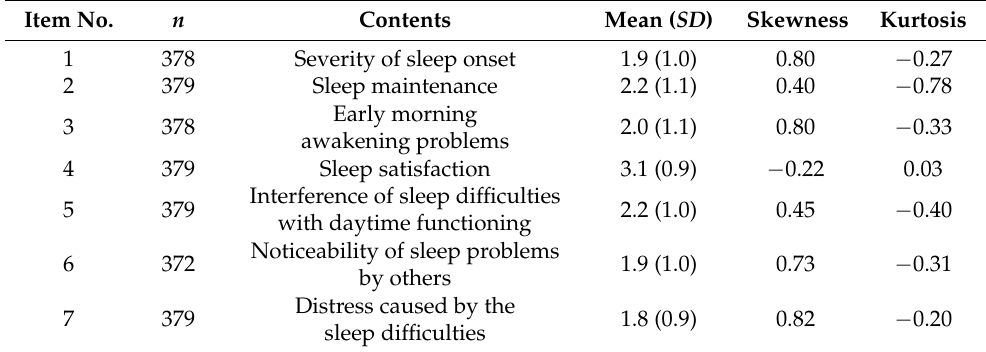
Table 1. Mean, SD , skewness, and kurtosis values of the ISI items ( n = 382). Item No.